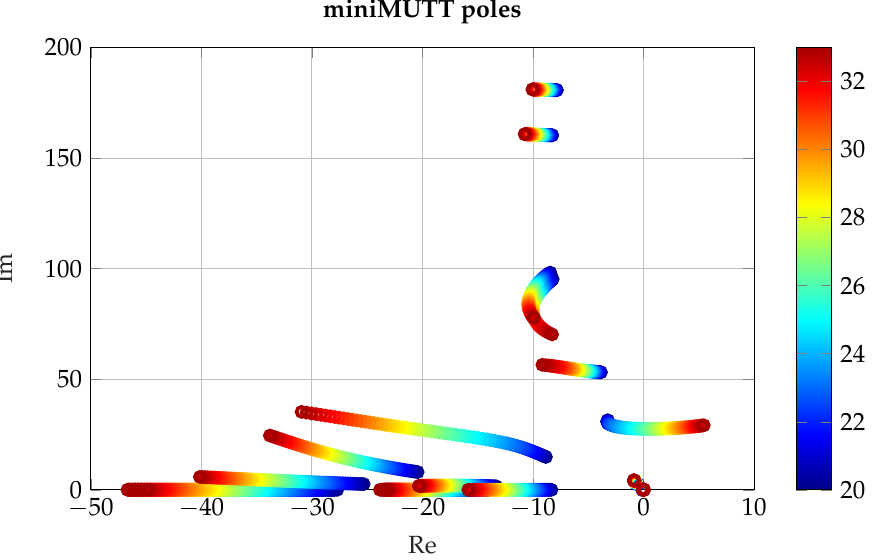
Figure 15. Pole migration of the reference model ( µ =